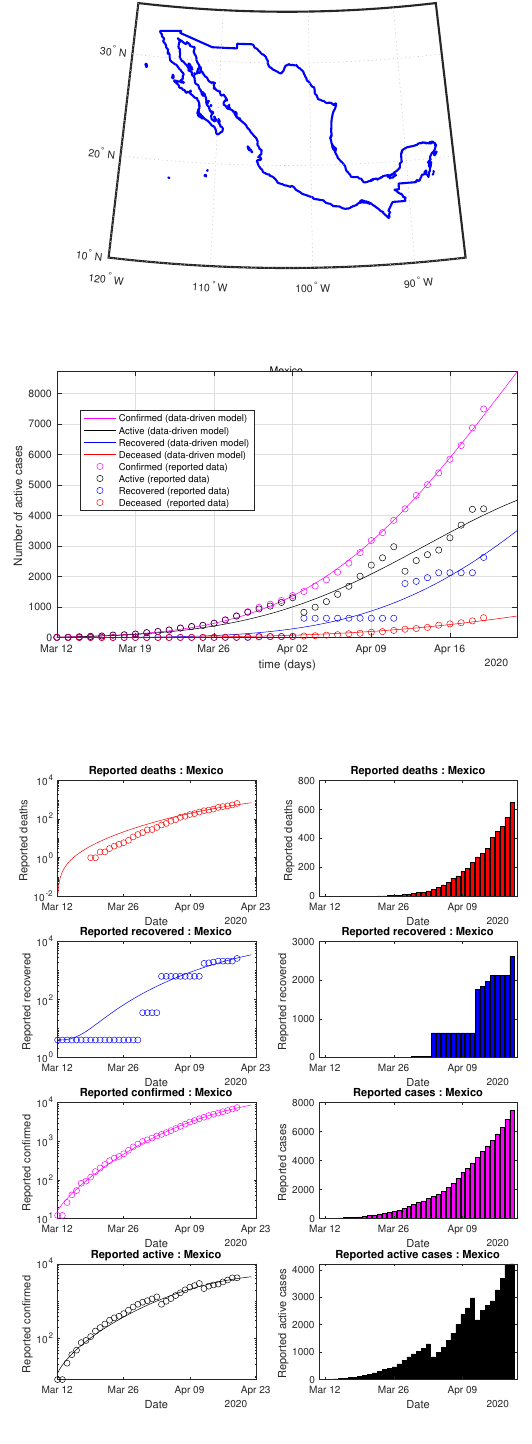
Figure 33. Mexico: data of active, recovered, deceased (in circle or bar) vs. model of active, recovered, deceased over time. Tracking the number of active cases over time. Predictive analytics for the next couple